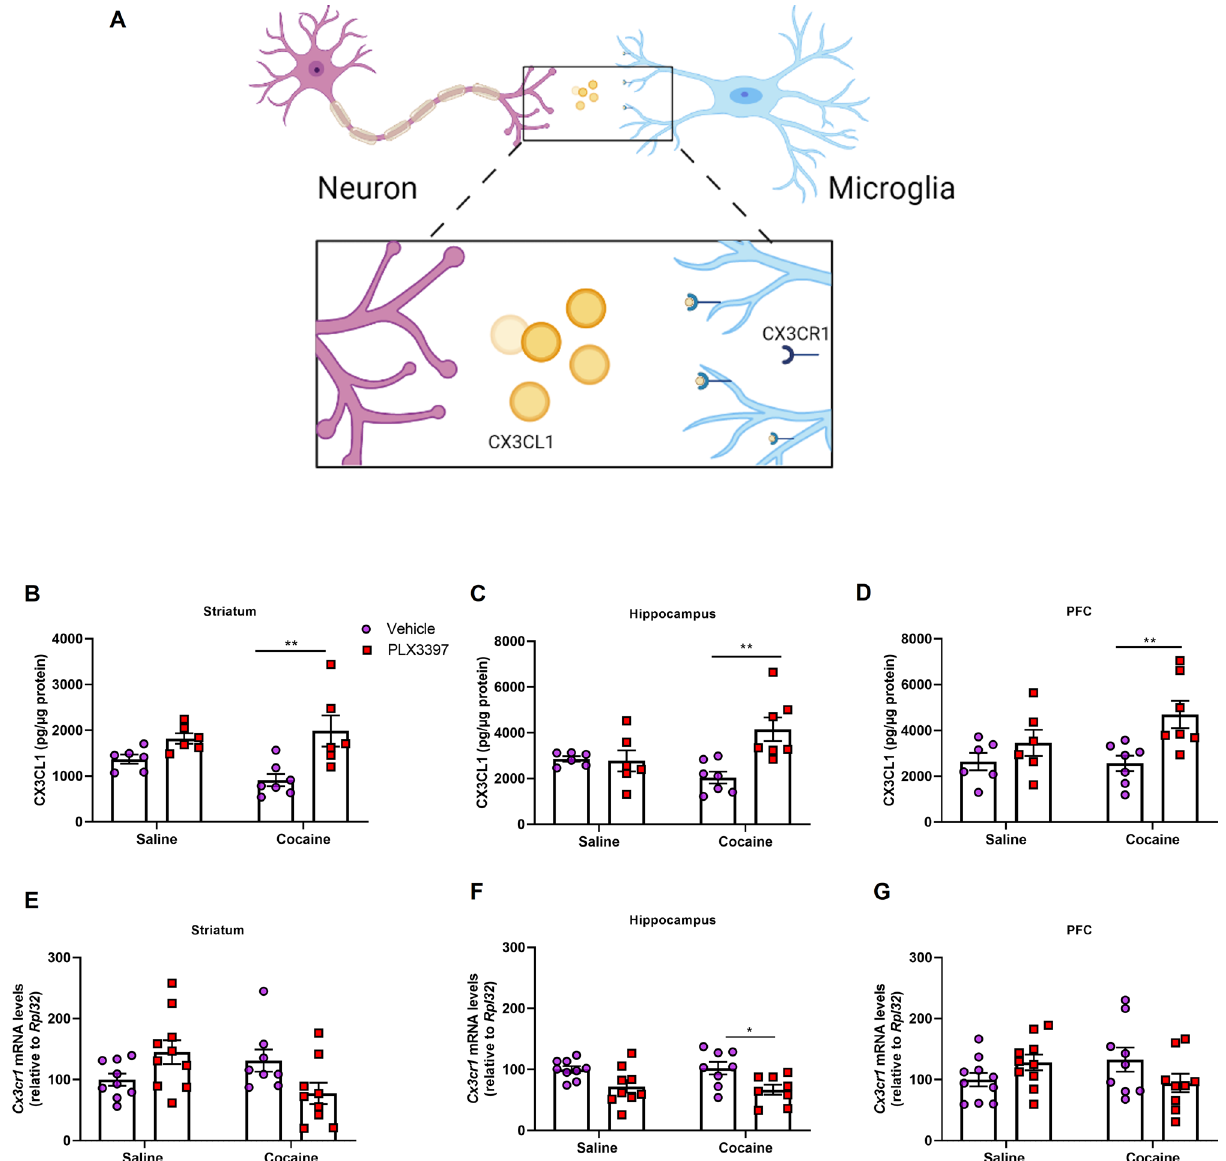
Figure 4. Effect of CSF1R inhibition and cocaine administration on CX3CL1 levels and CX3CR1 expression in the brain. Representative image of the CX3CL1-CX3CR1 pathway ( A ). Quantification of CX3CL1 in the striatum [cocaine factor (F (1,21) = 0.58; p = 0.4526), CSF1R inhibition factor (F (1,21) = 15.35; p = 0.0008) and cocaine vs CSF1R inhibition factor (F (1,21) = 2.58; p = 0.1230)] ( B ), hippocampus [cocaine factor (F (1,22) = 0.55; p = 0.4641), CSF1R inhibition factor (F (1,22) = 6.93; p = 0.0152) and cocaine vs CSF1R inhibition factor (F (1,22) = 8,23; p = 0.0089)] ( C ) and PFC [cocaine factor (F (1,22) = 1.42; p = 0.2456), CSF1R inhibition factor (F (1,22) = 9.17; p = 0.0062) and cocaine vs CSF1R inhibition factor (F (1,22) = 1.82; p = 0.1905)] ( D ) (n = 5–7 in each group). Quantification of CX3CR1 in the striatum [cocaine factor (F (1,32) = 1.16; p = 0.2896), CSF1R inhibition factor (F (1,32) = 0.06; p = 0.8031) and cocaine vs CSF1R inhibition factor (F (1,34) = 5.08; p = 0.0307) ( E ), hippocampus [cocaine factor (F (1,30) = 0.03; p = 0.8522), CSF1R inhibition factor (F (1,30) = 13.03; p = 0.0011) and cocaine vs CSF1R inhibition factor (F (1,30) = 0.18; p = 0.6716)] ( F ) and PFC [cocaine factor (F (1,34) = 0.00; p = 0.97), CSF1R inhibition factor (F (1,34) = 0.11; p = 0.7390) and cocaine vs CSF1R inhibition factor (F (1,32) = 8.57; p = 0.0062) ( G ) (n = 8–10 in each group). Results are expressed as mean ± SEM. *p < 0.05 and **p < 0.01 compared with the PLX3397 treated